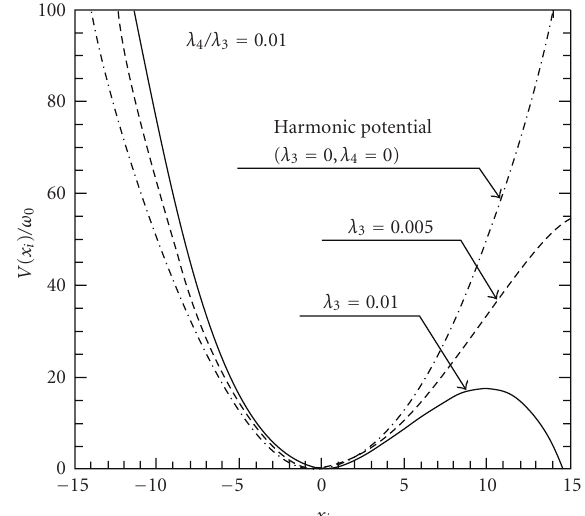
Figure 5: Anharmonic potential in units of ω 0 as a function of the one-dimensional lattice displacement x i for λ 3 = 0.005 and 0.01 with λ 4 /λ 3 = 0 . 01